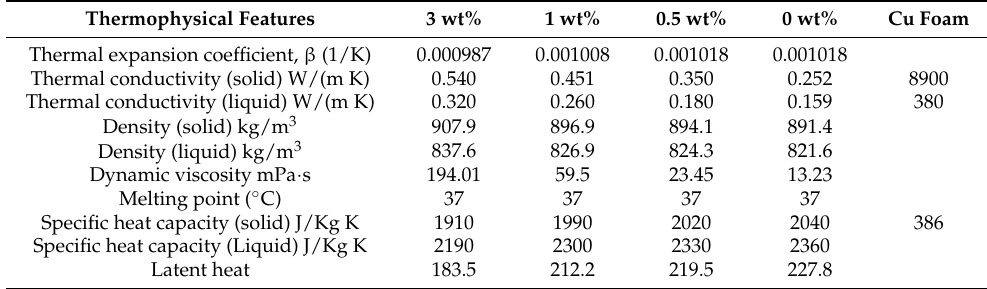
Table 1. Thermophysical features of NePCM-GNPs